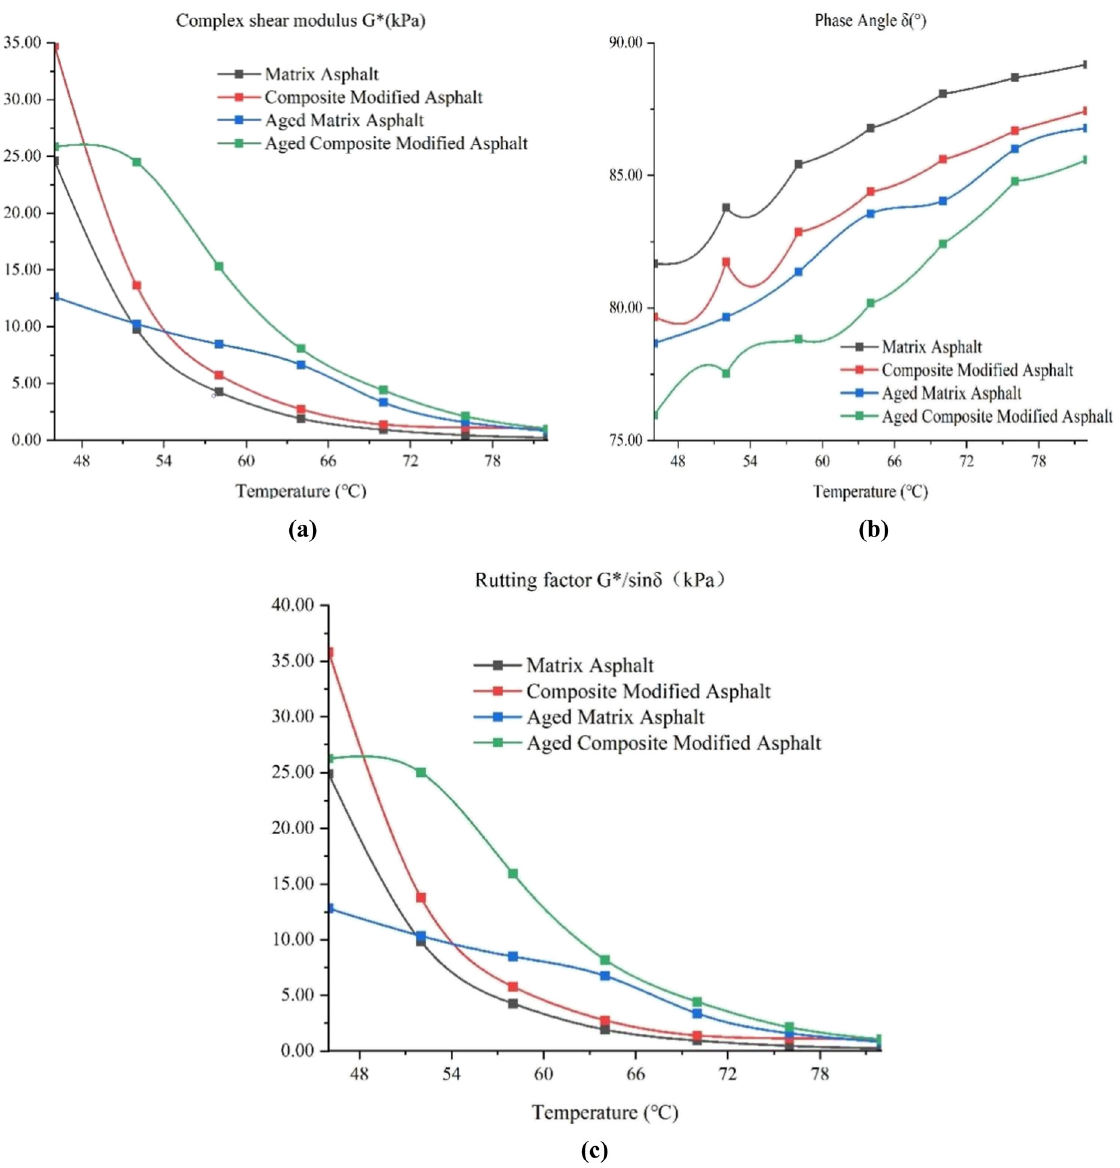
Figure 3: Di ff erent asphalts dynamic shear test results. ( a ) Di ff erent asphalts complex shear modulus, ( b ) di ff erent asphalts phase angle, and ( c ) di ff erent asphalts rutting factor.